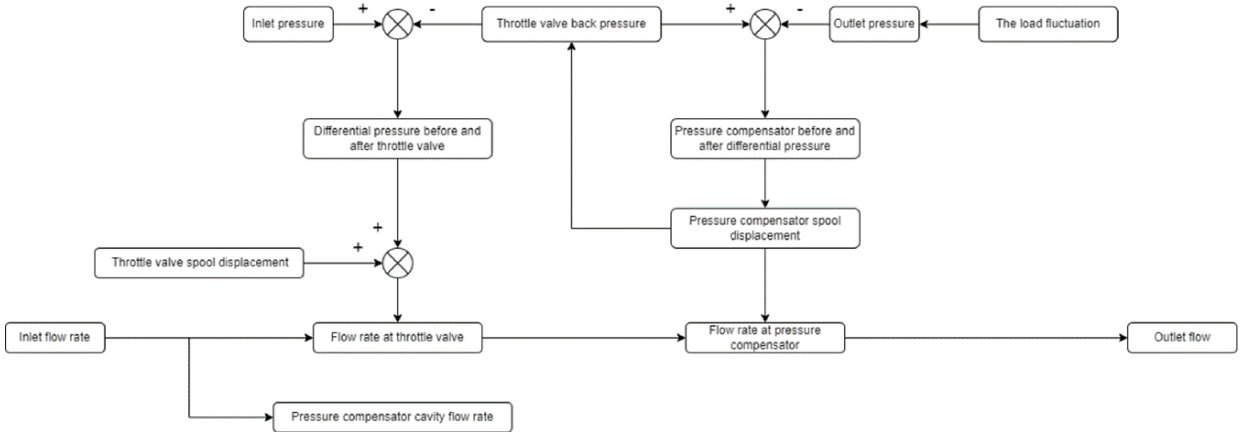
Figure 2. Flow chart of working principle of speed-regulating valve.